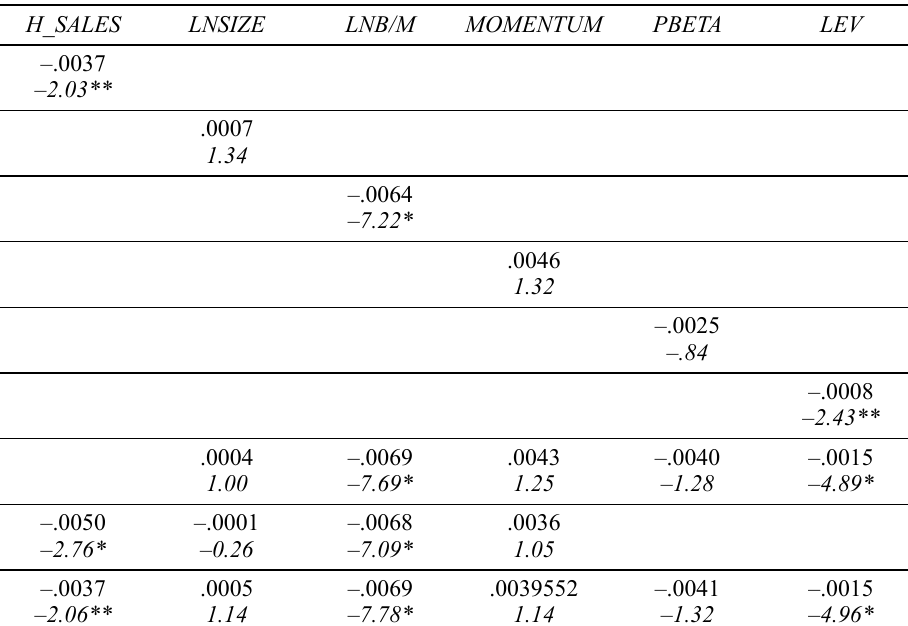
Table 4. Fama-MacBeth regressions of firm-level returns H_SALES LNSIZE LNB/M MOMENTUM